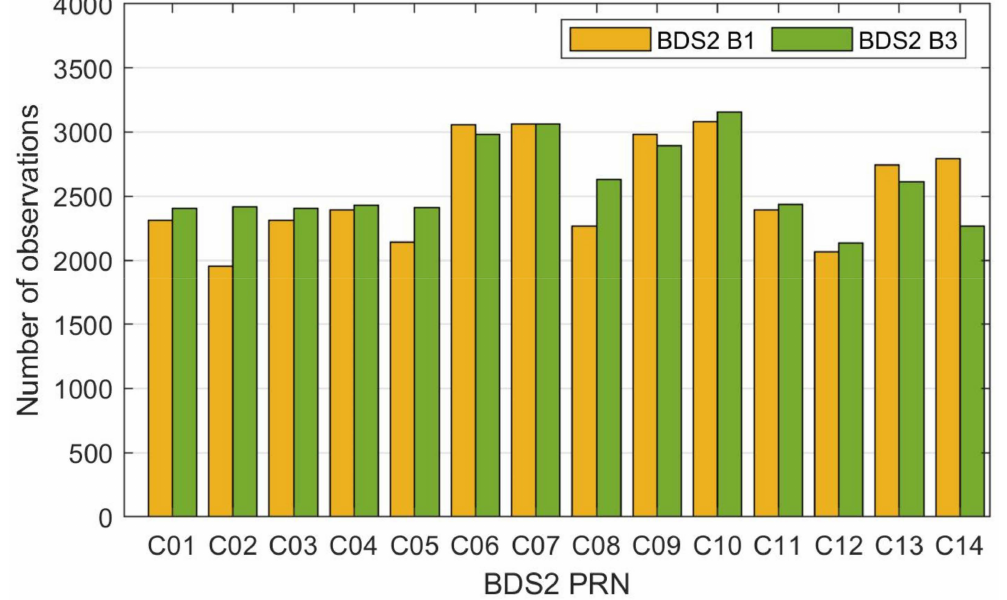
Figure 2. The number of observations for BDS2